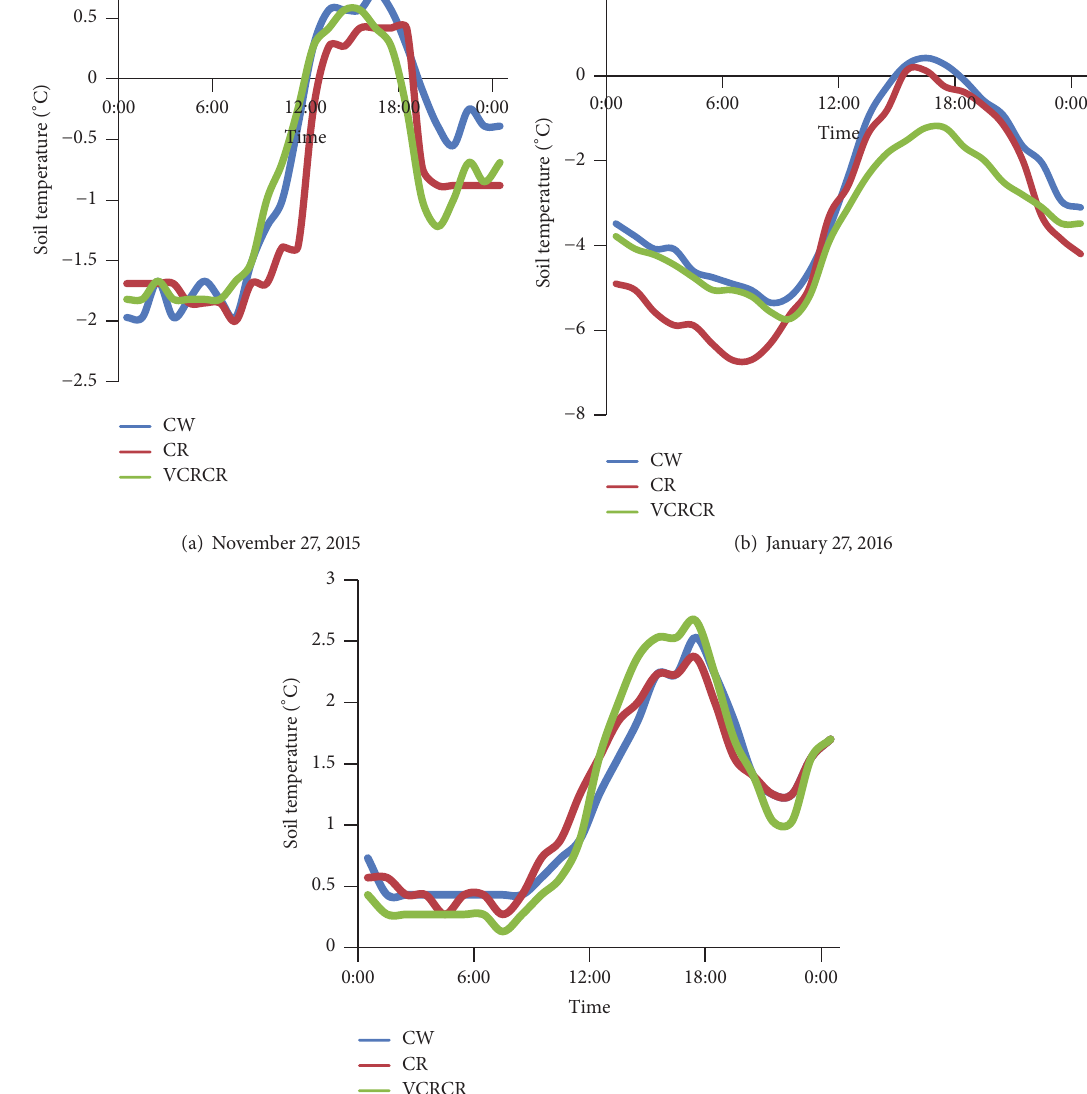
higher at the beginning and 1.28 ∘ C, 1.88 ∘ C, 5.33 ∘ C, and 5.31 ∘ C higher at the middle of wintering period than 40 cm, 20